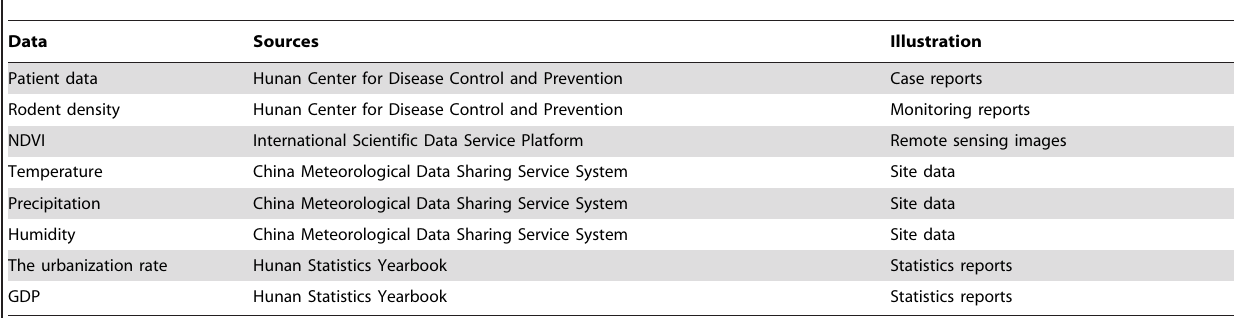
Table 1. Data sources and